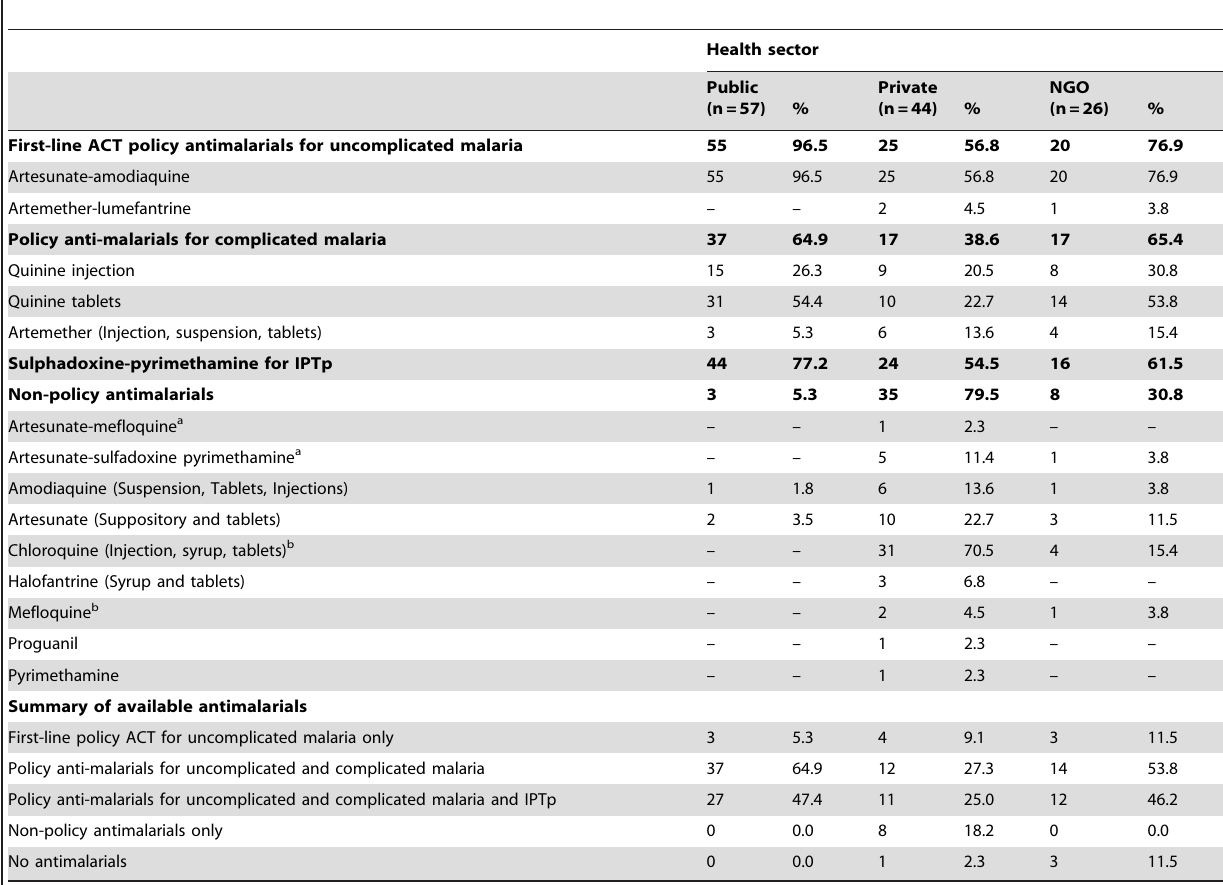
Table 1. Availability of antimalarials in the public, private, and charitable health facilities